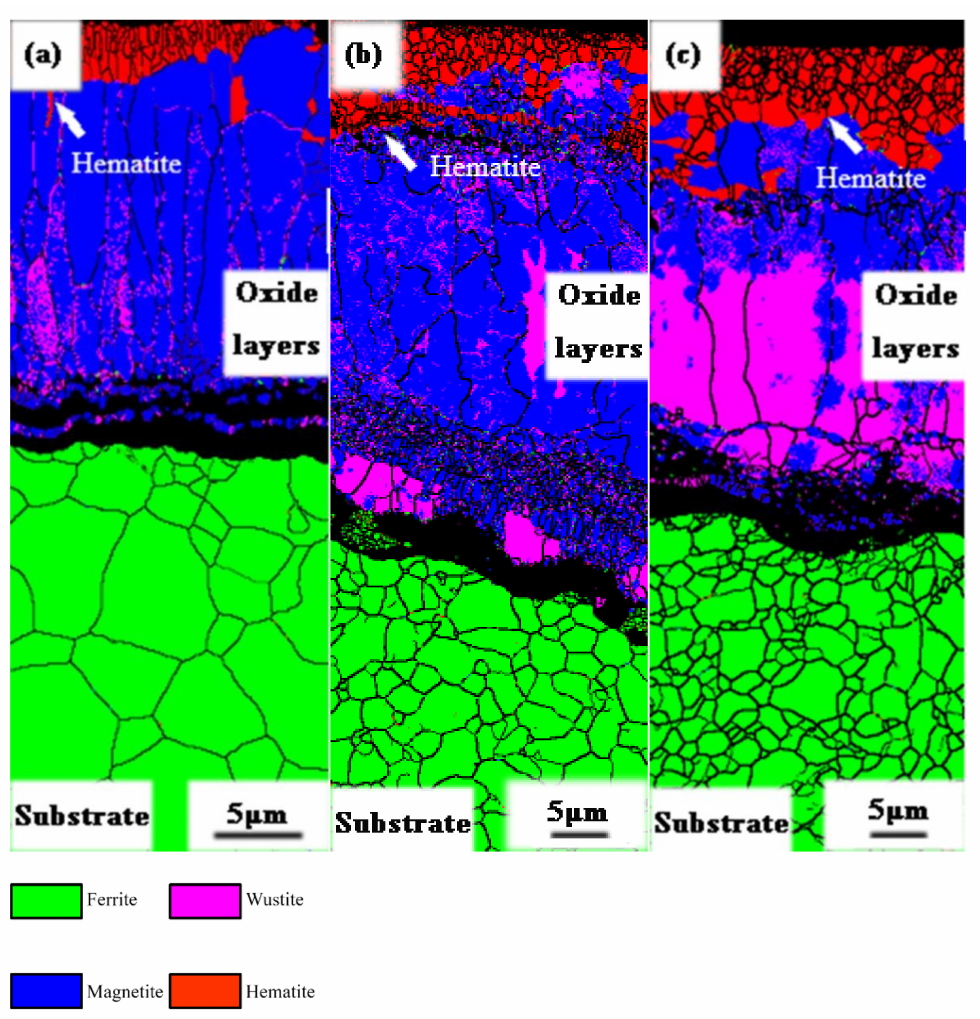
Figure 4. EBSD phase maps of the high strengh steel reheated at 920 ◦ C, cooled to 870 ◦ C, with the reduction rate and cooling rates of ( a ) 10 %, 11 ◦ C/s, ( b ) 15%, 18 ◦ C/s, and ( c ) 27 %, 27 ◦